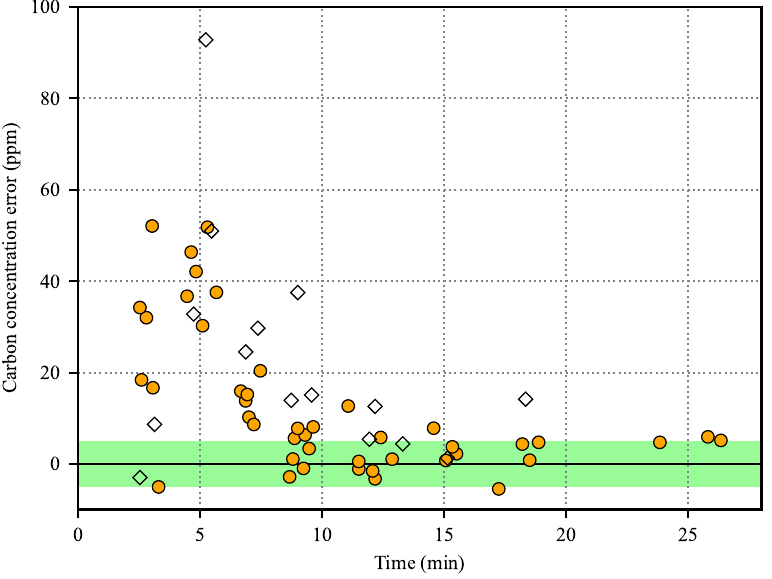
Figure 5. Prediction errors between the output of the decarburization curves using the TDLAS analyzer and the actual carbon concentrations. Empty diamonds and filled circles represent operations with or without additional carbon, respectively. A prediction is considered excellent if the prediction error is within ±5 ppm (green